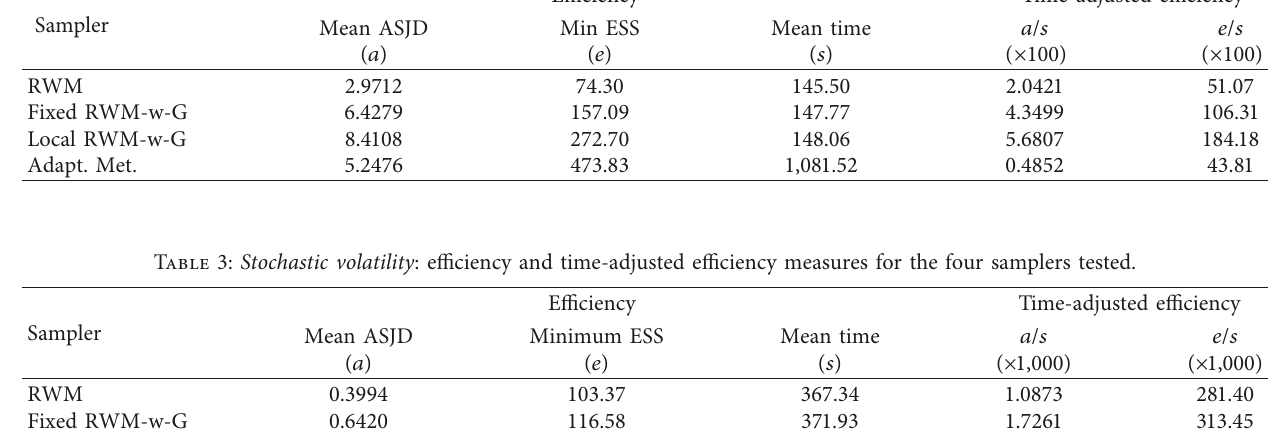
Table 2: Scottish dataset : efficiency and time-adjusted efficiency measures for the four samplers tested. Sampler